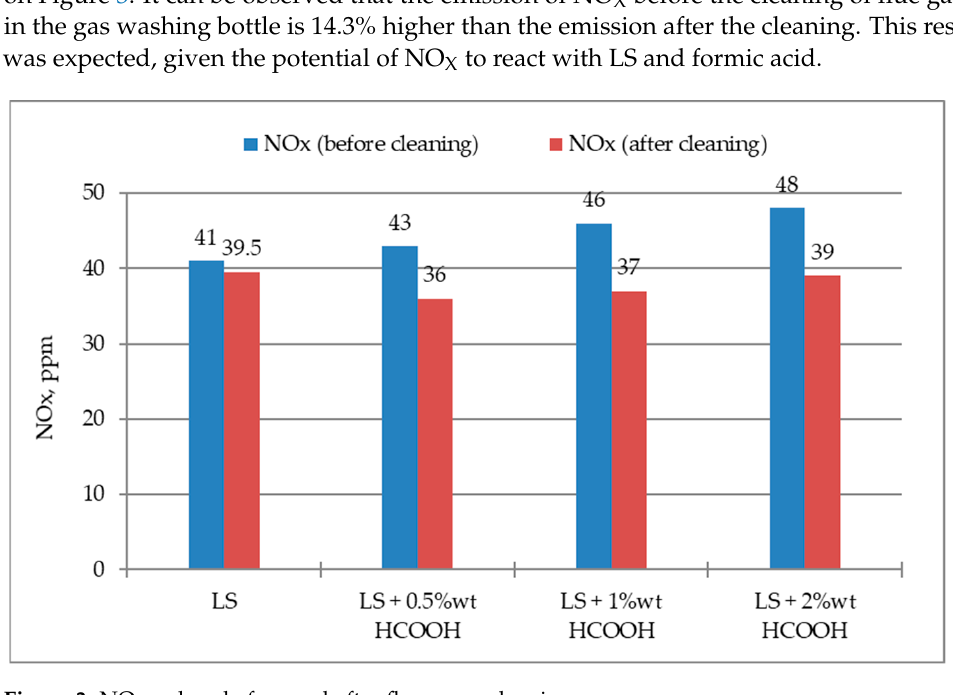
Figure 3. NO X values before and after flue gases cleaning.